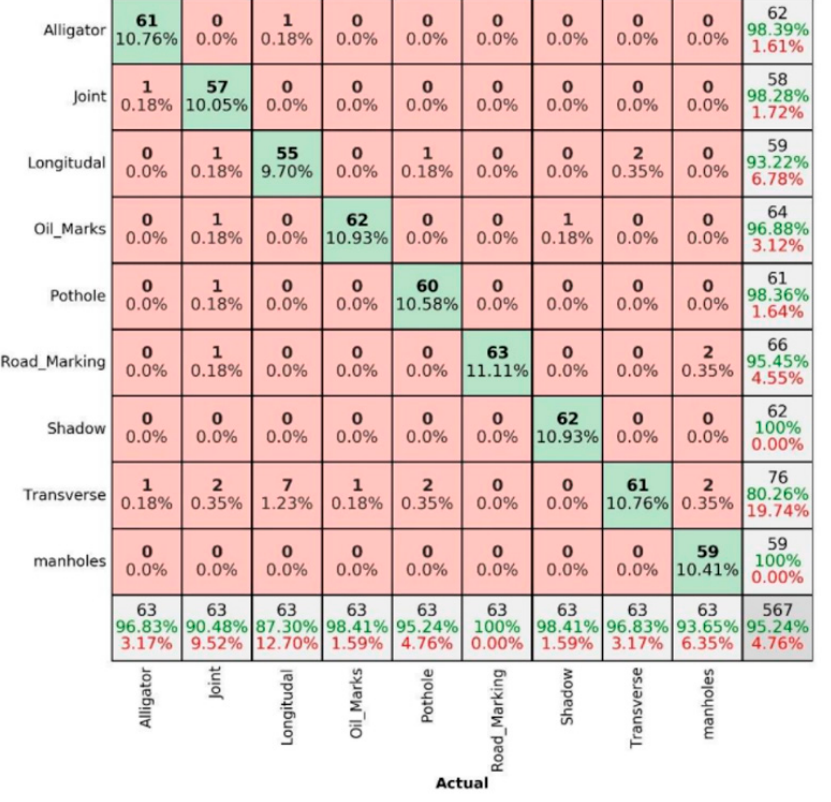
Figure 10. Winter sunny condition—IR-T images.